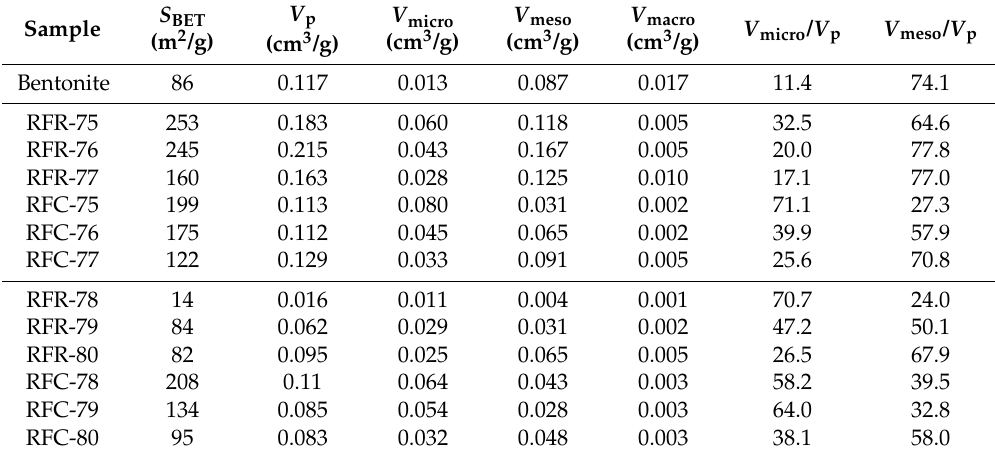
Table 1. Structural characteristics of tested